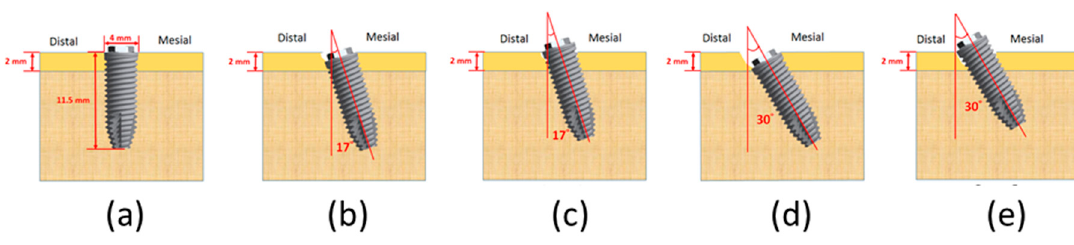
Figure 2. ( a ) Group 1: vertical implant in an evencrestal position; ( b ) Group 2: 17 ◦ tilted implant in a distal subcrestal position; ( c ) Group 3: 17 ◦ tilted implant in a mesial supracrestal position; ( d ) Group 4: 30 ◦ tilted implant in a distal subcrestal position; ( e ) Group 5: 30 ◦ tilted implant in a mesial